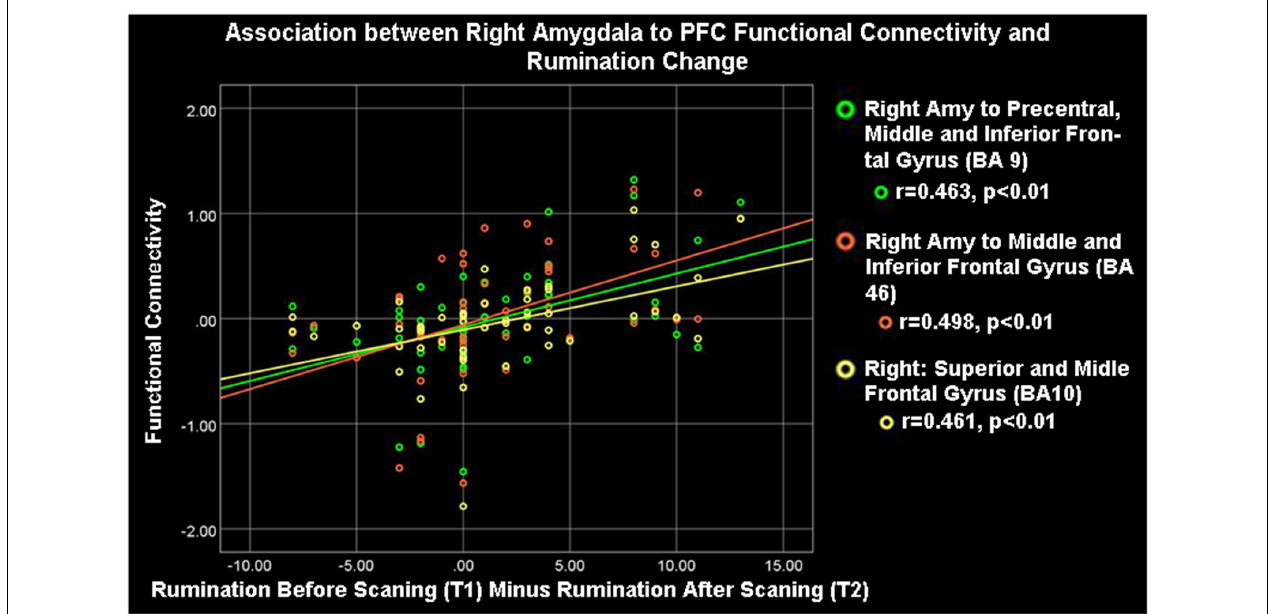
FIGURE 3 | Right amygdala (Amy) to ipsilateral frontocortical connectivity and rumination change. High rumination change was significantly associated with high right amygdala-PFC connectivity during the neurofeedback procedure (ESOM-NF task).